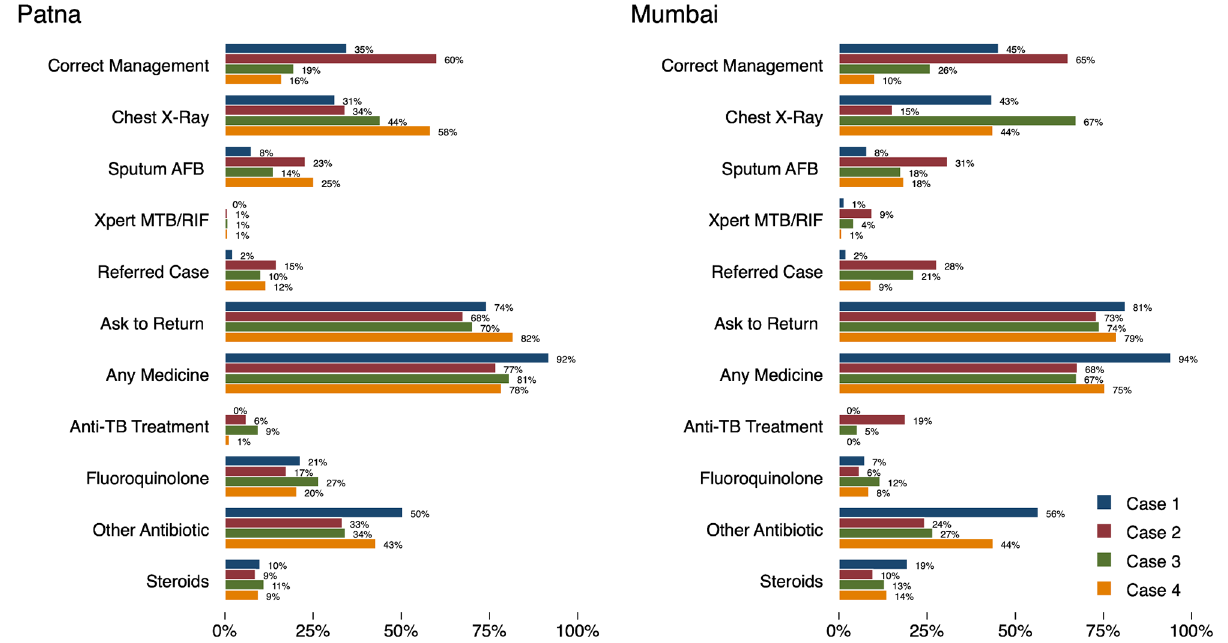
Fig 1. City-representative quality of care estimates. City-level estimates of quality of care for each of our case scenarios. These proportions represent the estimated frequency with which the action would be observed if the standardized case scenario was presented to a provider randomly selected from the sampling frame. These estimates are calculated using inverse probability weights corresponding to the sample frame as detailed in S2 Text for every city–qualification–PPIA–case combination in the data. N = 2,602. AFB, acid-fast bacilli; PPIA, Private Provider Interface Agency; TB, tuberculosis; Xpert MTB/RIF, Xpert Mycobacterium tuberculosis/Rifampicin, also known as GeneXpert.